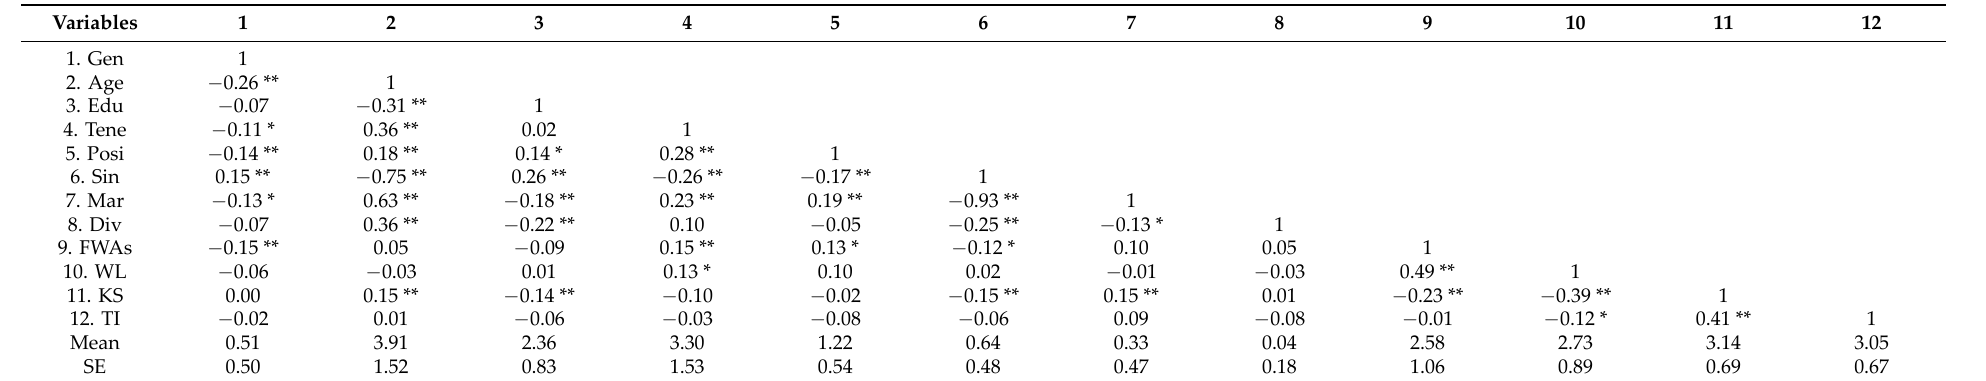
Table A2. Summary statistics and correlations of Study